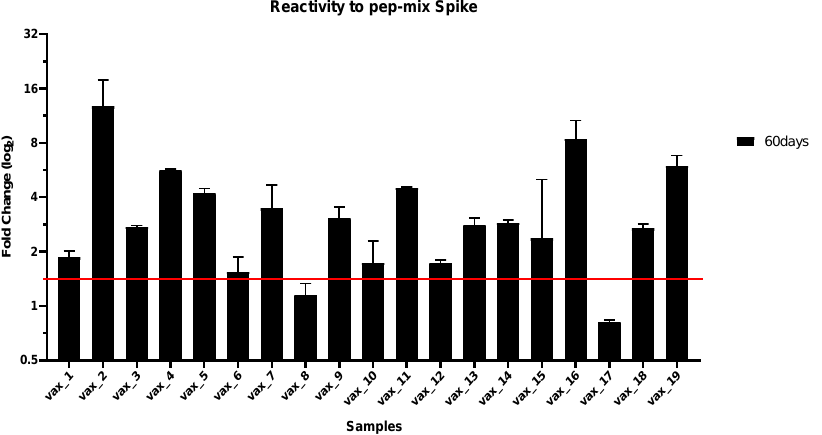
Figure 2. IgG immunoreacting 60 days after administration of the first dose of the Pfizer/BioNTech vaccine using the mixed peptides as the immuno-adsorbent phase. The antibody response is reported as a log 2 fold-change of ELISA absorbance at day 60 with respect to day 0, when all participants, except vax_8 , were seronegative to anti-SARS-CoV-2 antibodies.